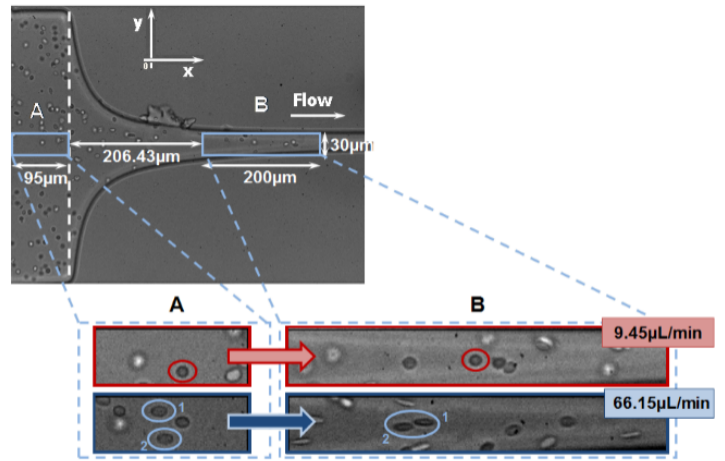
Figure 3. RBC deformability in a hyperbolic converging microchannel at two different regions ( A ) and ( B ) and flow rates (9.45 µ L/min and 66.15 µ L/min) (adapted from